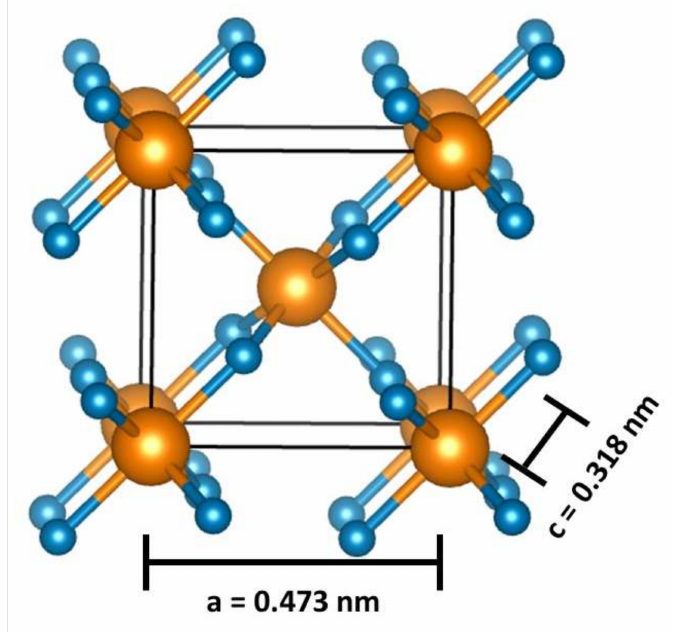
Figure 3. Unit cell of the tetragonal cassiterite structure of the SnO 2 . The Sn is represented by the orange spheres and O is represented by the blue